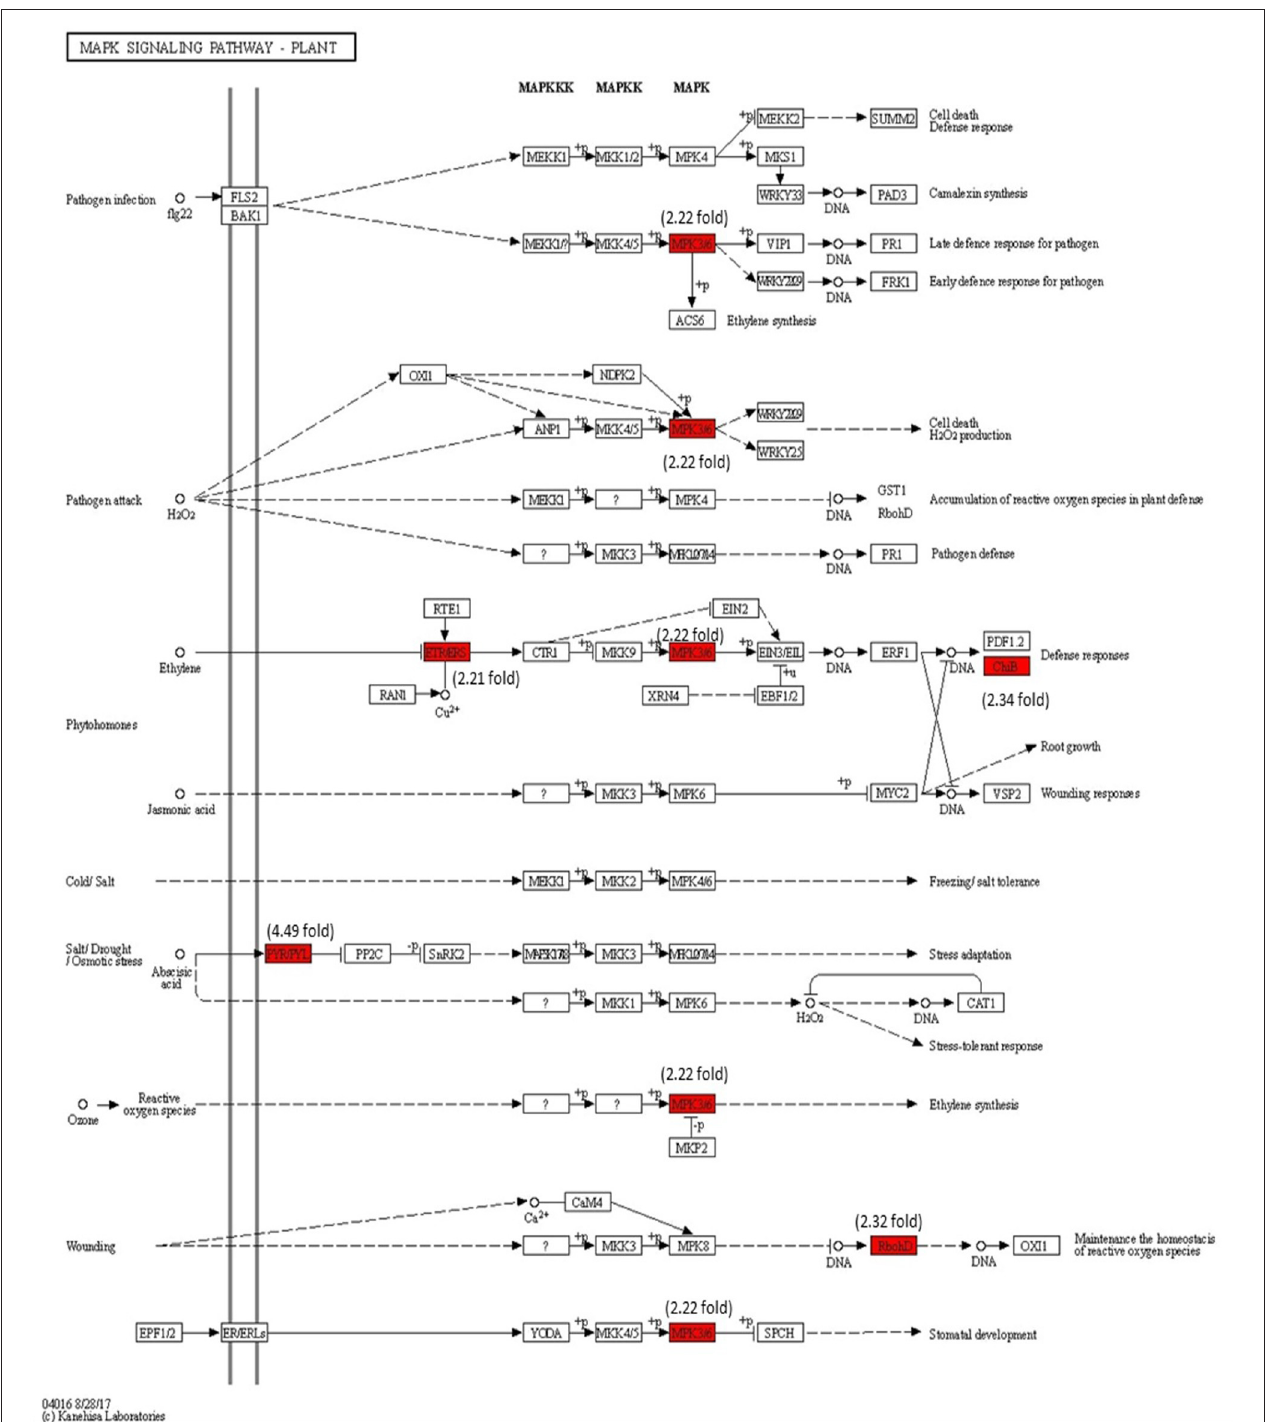
FIGURE 10 | Modulation of gene expression in MPK signaling transduction pathway in tomato plant by Cg-2 treatment. (Red color represents the upregulated genes, and green color represents the downregulated genes).